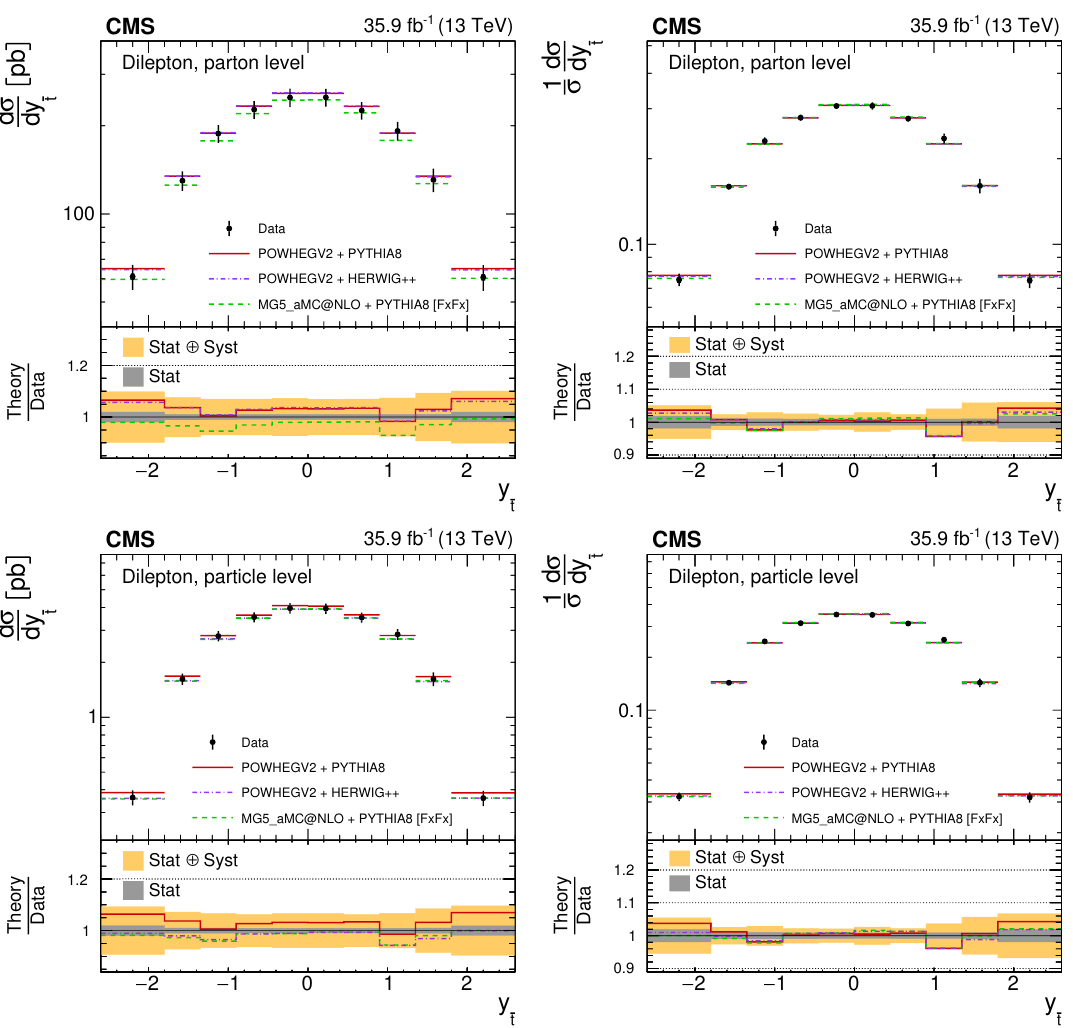
Figure 15 . The di(cid:11)erential tt production cross sections as a function of y data (points) and the MC predictions (lines). The vertical lines on the points indicate the total uncertainty in the data. The left and right columns correspond to absolute and normalised mea- surements, respectively. The upper row corresponds to measurements at the parton level in the full phase space and the lower row to the particle level in a (cid:12)ducial phase space. The lower panel in each plot shows the ratios of the theoretical predictions to the data. The dark and light bands show the relative statistical and total uncertainties in the data, respectively.